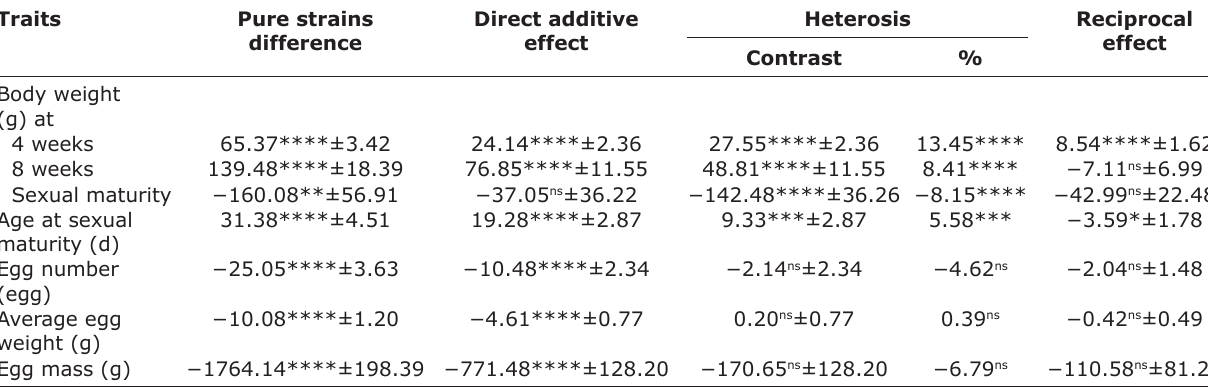
Table-3: Crossing estimates (±standard error) of body weight and egg traits.